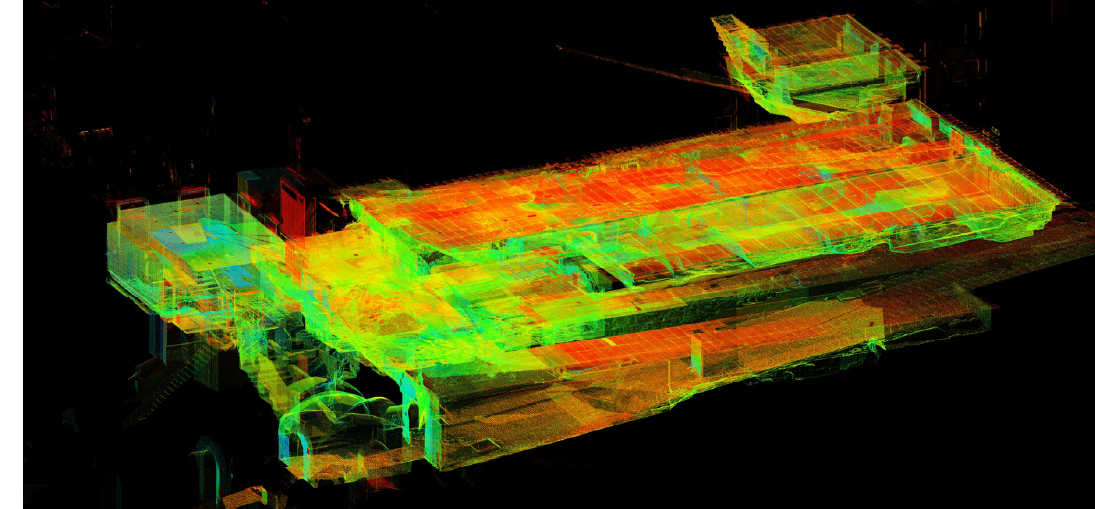
Figure 16. Geo ‐ referenced point cloud of the Aula Magna.